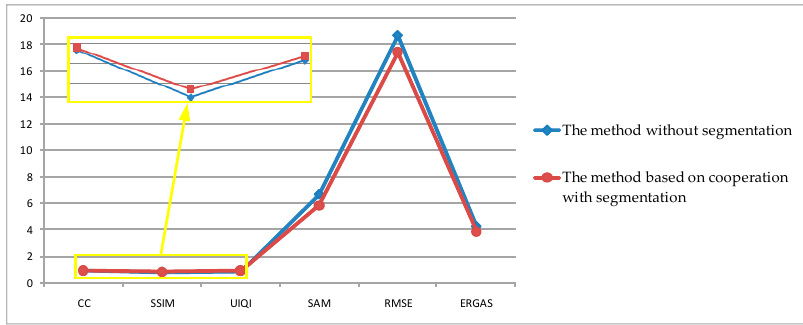
Figure 5. Performance of fusion results of Figure 4b,c.